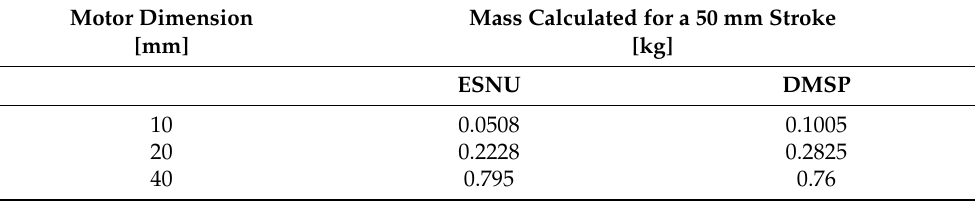
Table 3. Masses of the studied pneumatic